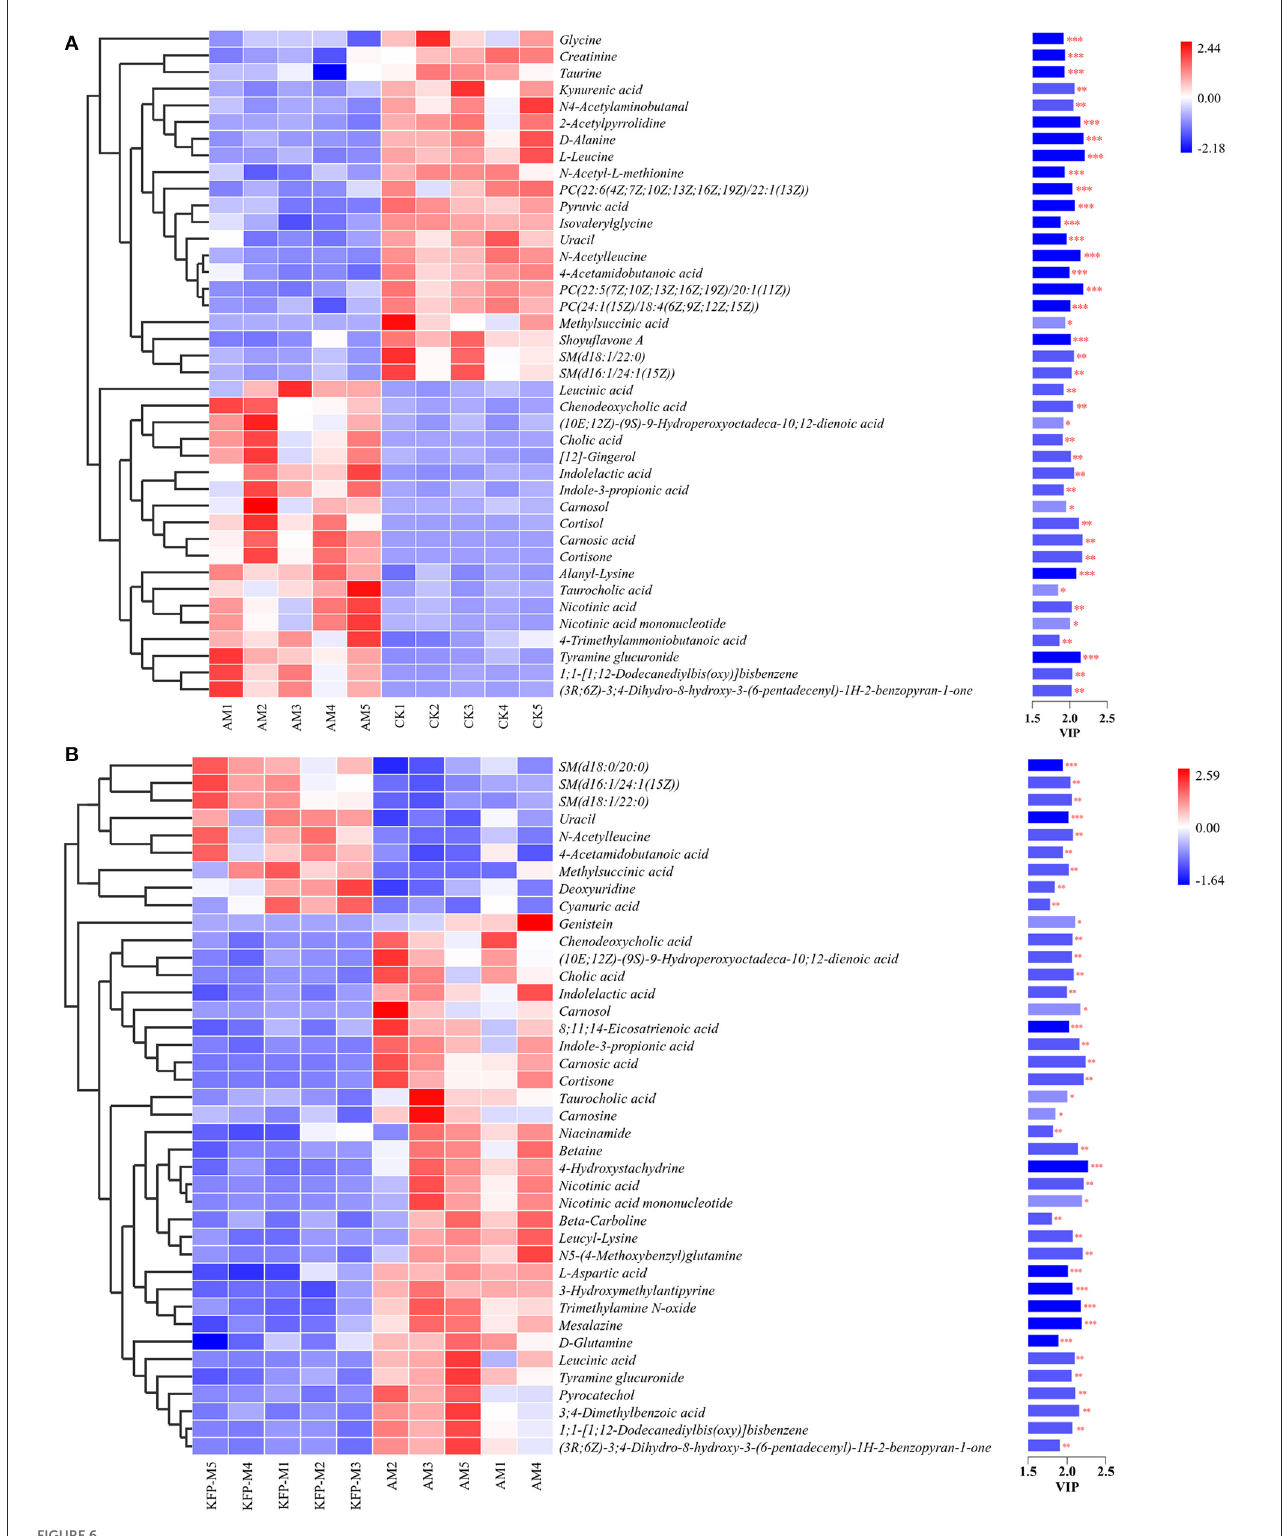
FIGURE6 Heatmap of the screened most important 59 metabolites between (A) CK vs. AM groups and (B) AM vs. KFP-M groups. Significant difference between groups was represented as *** p < 0.001, ** p < 0.01, and * p < 0.05. CK, control group; AM, acrylamide model group; KFP-M, medium-dose KFP group. Each group consisted of five